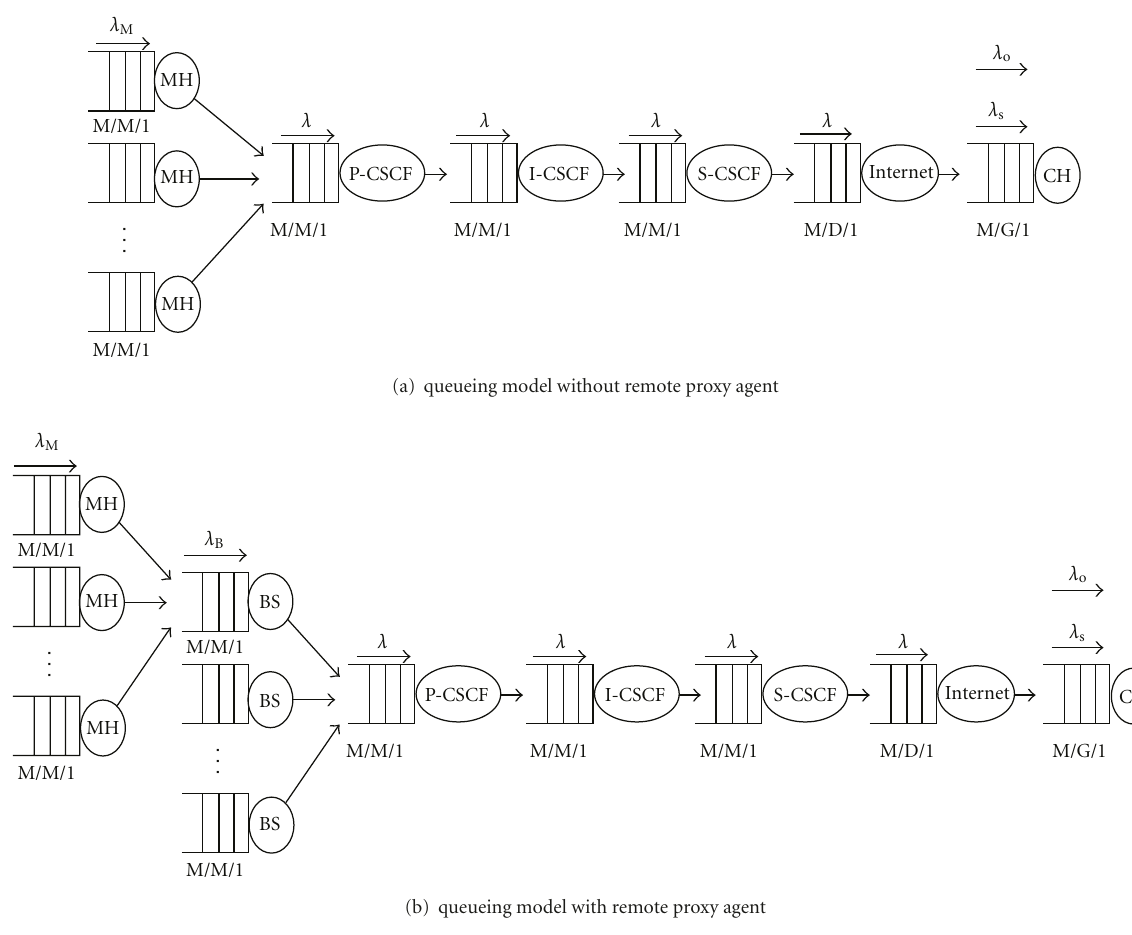
Figure 5: Queueing model for analyzing the delay in SIP session re-setup